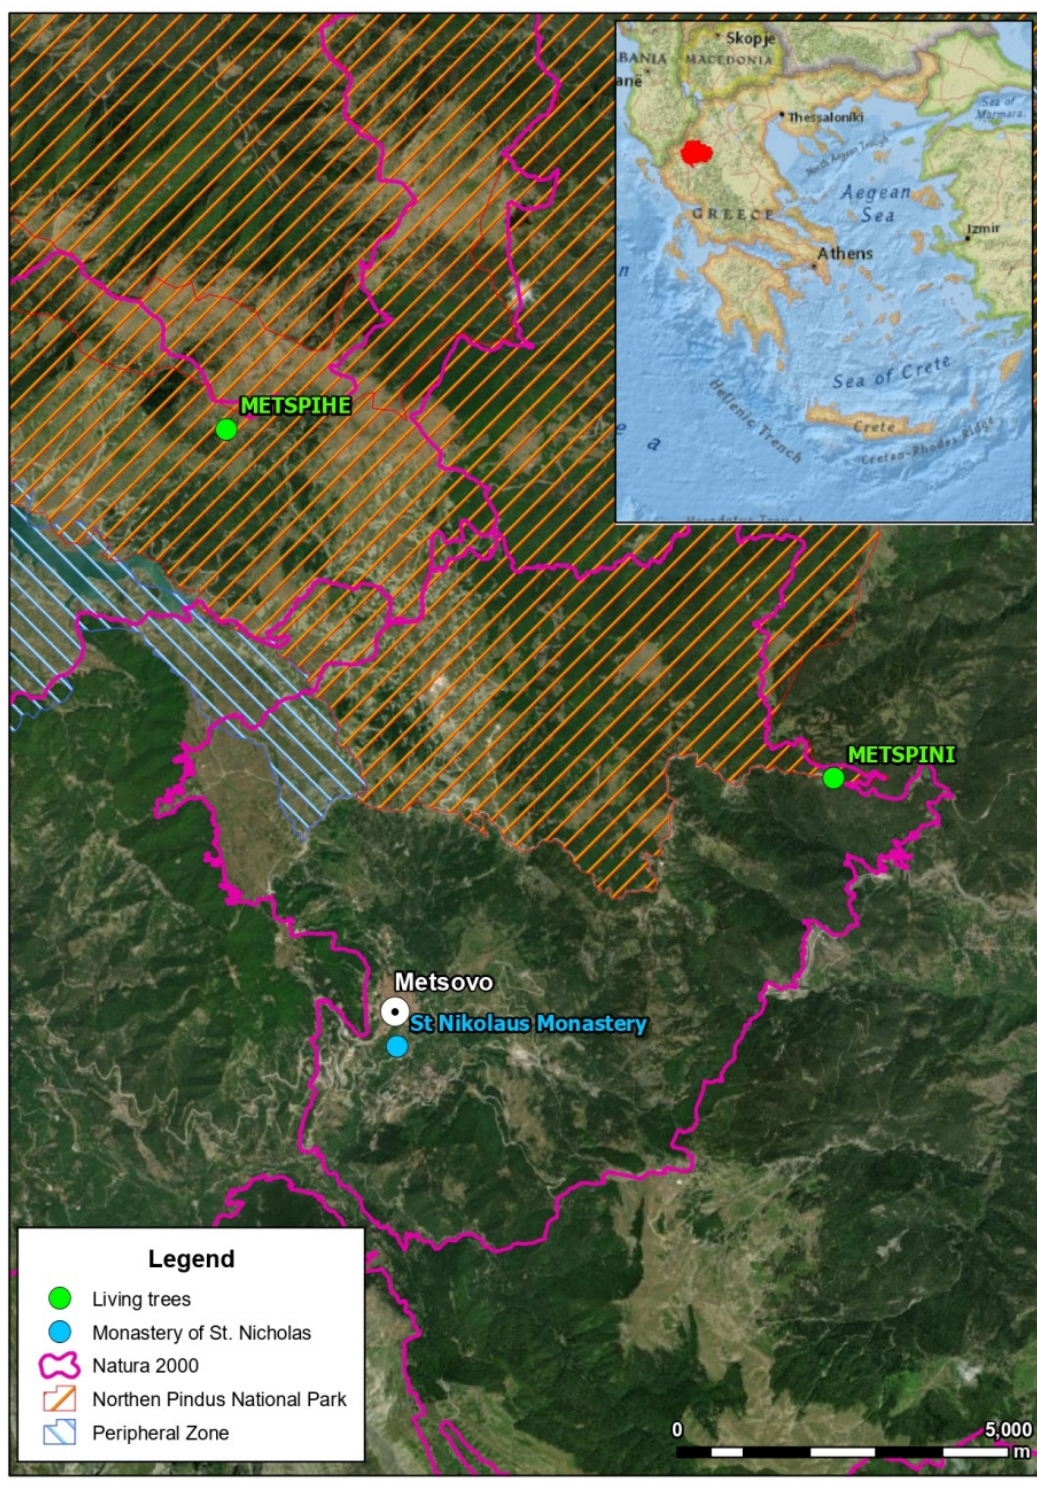
Figure 1. Location of the broader study area within the borders of the Northern Pindus National Park and the different study sites where samples were collected from historical timber (blue dot) and living trees (green dots): (1) METSPIHE: Bosnian pine forest, (2) METSPINI: Black pine forest.